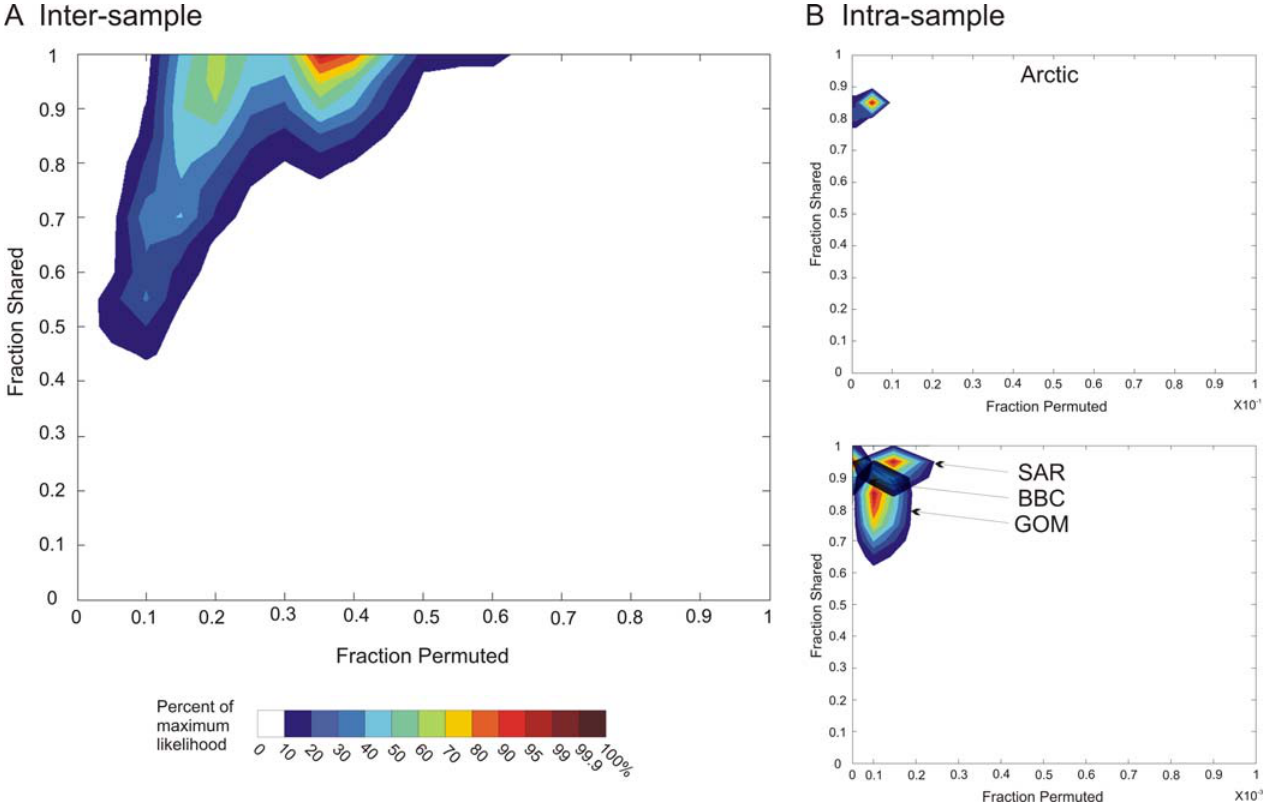
Figure 6. Monte Carlo Simulation of Cross-Contigs between Metagenomic Samples (A) For the intersample analysis, the maximum likelihood occurred at 35% fraction permuted and 100% fraction shared. (B) The maximum likelihood was between 0% and 0.5% fraction permuted and 85% and 95 % fraction shared for the intrasample controls. DOI: